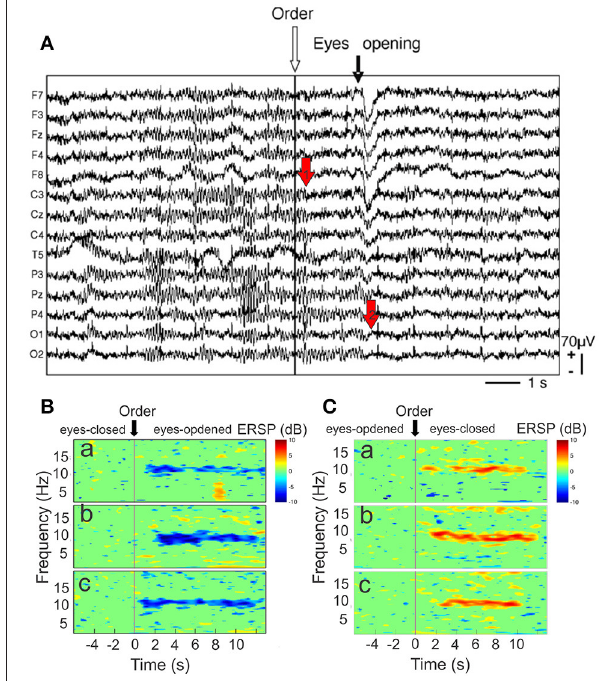
FIGURE 6 | (A) Raw EEG recordings during the arrest reaction. Fourteen EEG channels referenced to linked mastoid (from F7 top) to O2 (bottom). The white arrow indexes to the order to open the eyes. The black arrow points to the onset of the eye movement artifact related to eye opening, mainly recorded by frontal electrodes (F7, F3, FZ, F4, F8). Note that the amplitude of mu rhythm [recorded by central electrodes (C3, CZ, C4)] is reduced before eye opening (red arrow “1”) whereas alpha rhythm (P3, P4, PZ, O1, O2) is only reduced after this movement when the eyes are closed. Event-related spectral perturbation (ERSP) time-locked to the order of eyes opening. (B) ERSP-image plot of the color-coded single trials of the EEG spectrum recorded in P3 channel in one cosmonaut on Earth before the flight (a) , in weightlessness (b) , and on Earth after the flight (c) . The trials are time-locked to the order to open the eyes (stripped line). Blue color indicates a decrease in power. (C) ERSP-image plot for the same electrode, condition and participant as in (B) , but time-locked to the order of eyes closing. Red color indicates an increase in power (modified from Cheron et al., 2006, with